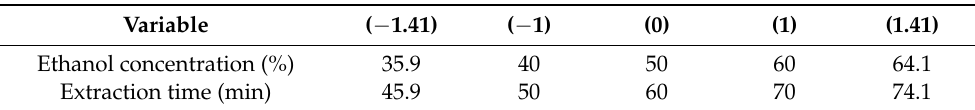
Table 5. Areas of variation of the experimental conditions necessary to improve the extraction of polyphenols from apples using